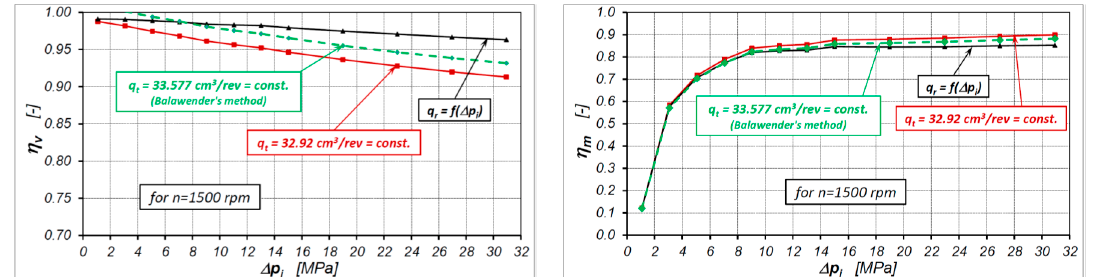
Figure 17. Comparison of volumetric efficiency η v (on the left ) and mechanical efficiency η m (on the right ) of the satellite motor at n = 1500 rpm for different working volumes.